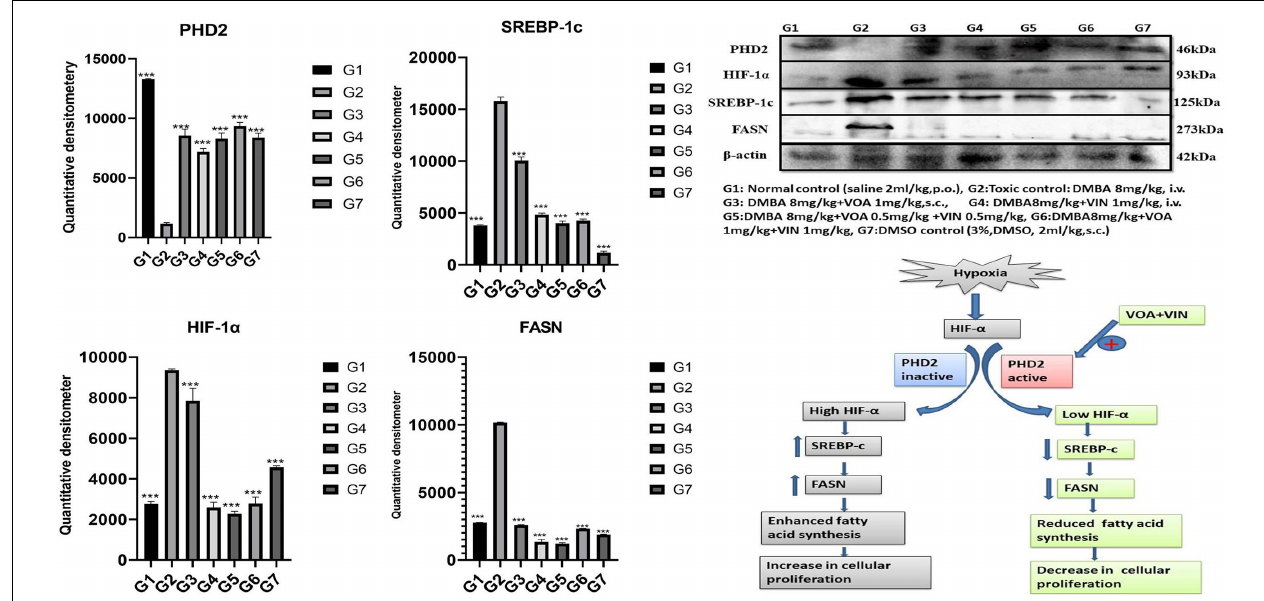
FIGURE 6 | Effect of VOA and VIN on hypoxic markers and fatty acid synthesis markers. Immunoblotting of the respective group [NC, normal control (saline 2 ml/kg); G2, toxic control (DMBA 8 mg/kg, i.v.); G3, voacamine (VOA) (1 mg/kg, s.c.); G4, vincristine (VIN) (1 mg/kg, i.v.); G5, VOA (0.5 mg/kg, s.c.) + VIN (0.5 mg/kg, i.v.); G6, VOA (1 mg/kg, s.c.) + VIN (1 mg/kg, i.v.); and DC-DMSO 3% (2 ml/kg)] for HIF-1 α , PHD-2, SREBP-1c, and FASN concluded the hypoxic microenvironment after DMBA administration. Values are presented as the mean ± standard deviation. Comparisons were made using one-way ANOVA followed